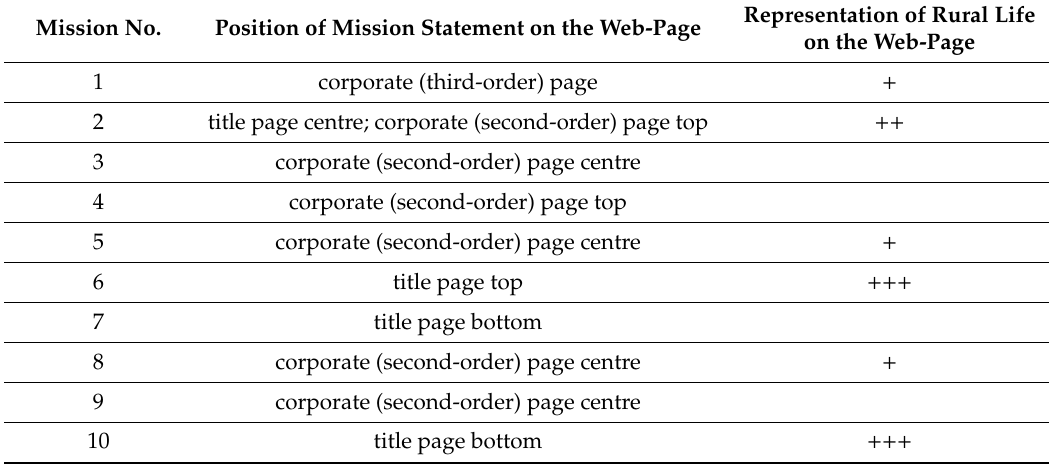
Table 4. Mission statements and web-pages of the analyzed organizations. Mission No. Position of Mission Statement on the Web-Page